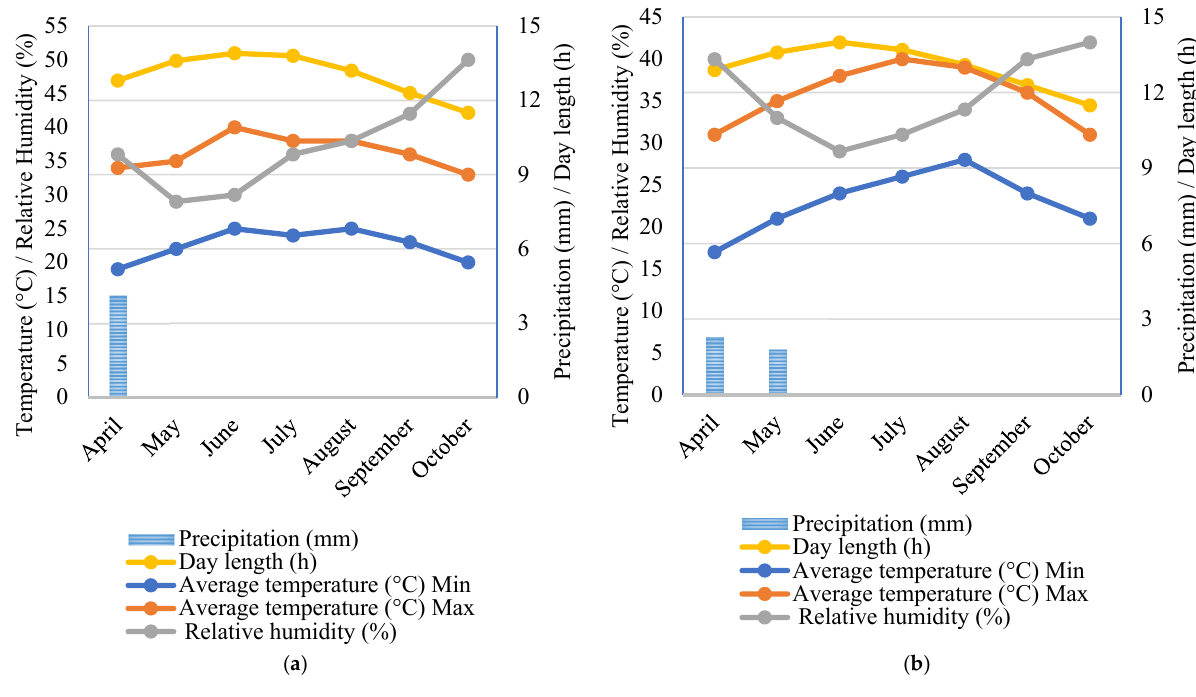
Figure 4. Monthly air temperature (°C), relative humidity (%), precipitation (mm), and day length (h) in the first ( a ) and second growing seasons ( b ).